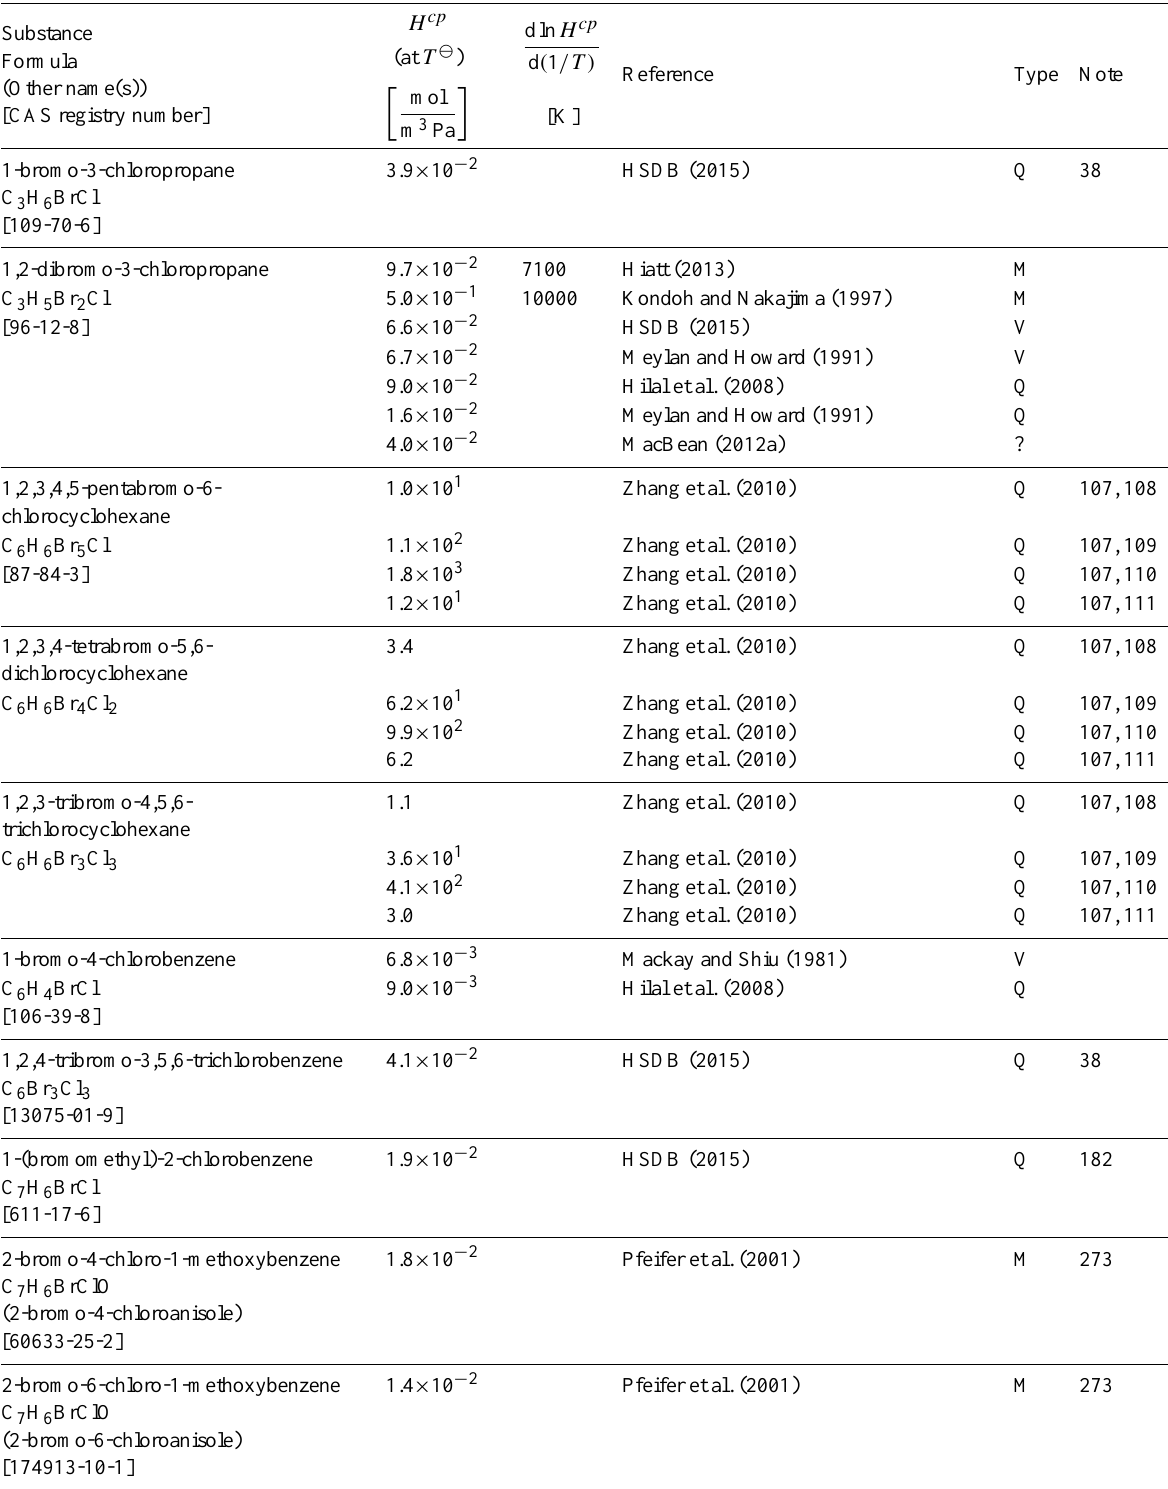
Table 6: Henry’s law constants for water as solvent